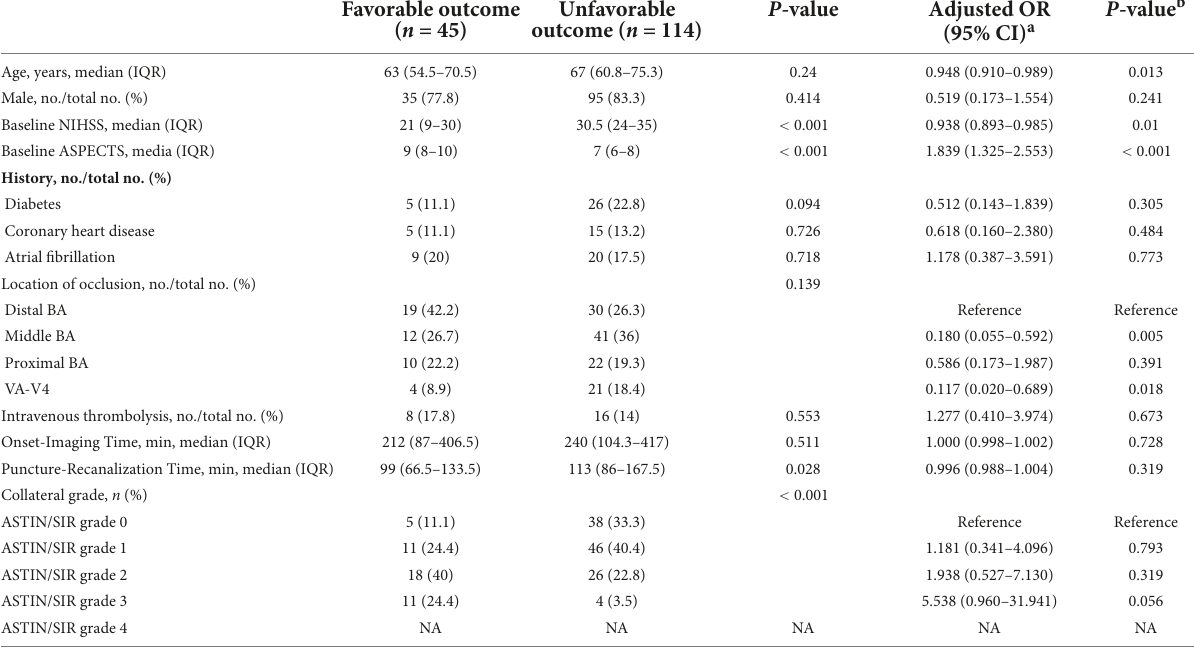
TABLE 3 Factors associated with favorable outcomes at 90 days of VBD patients.